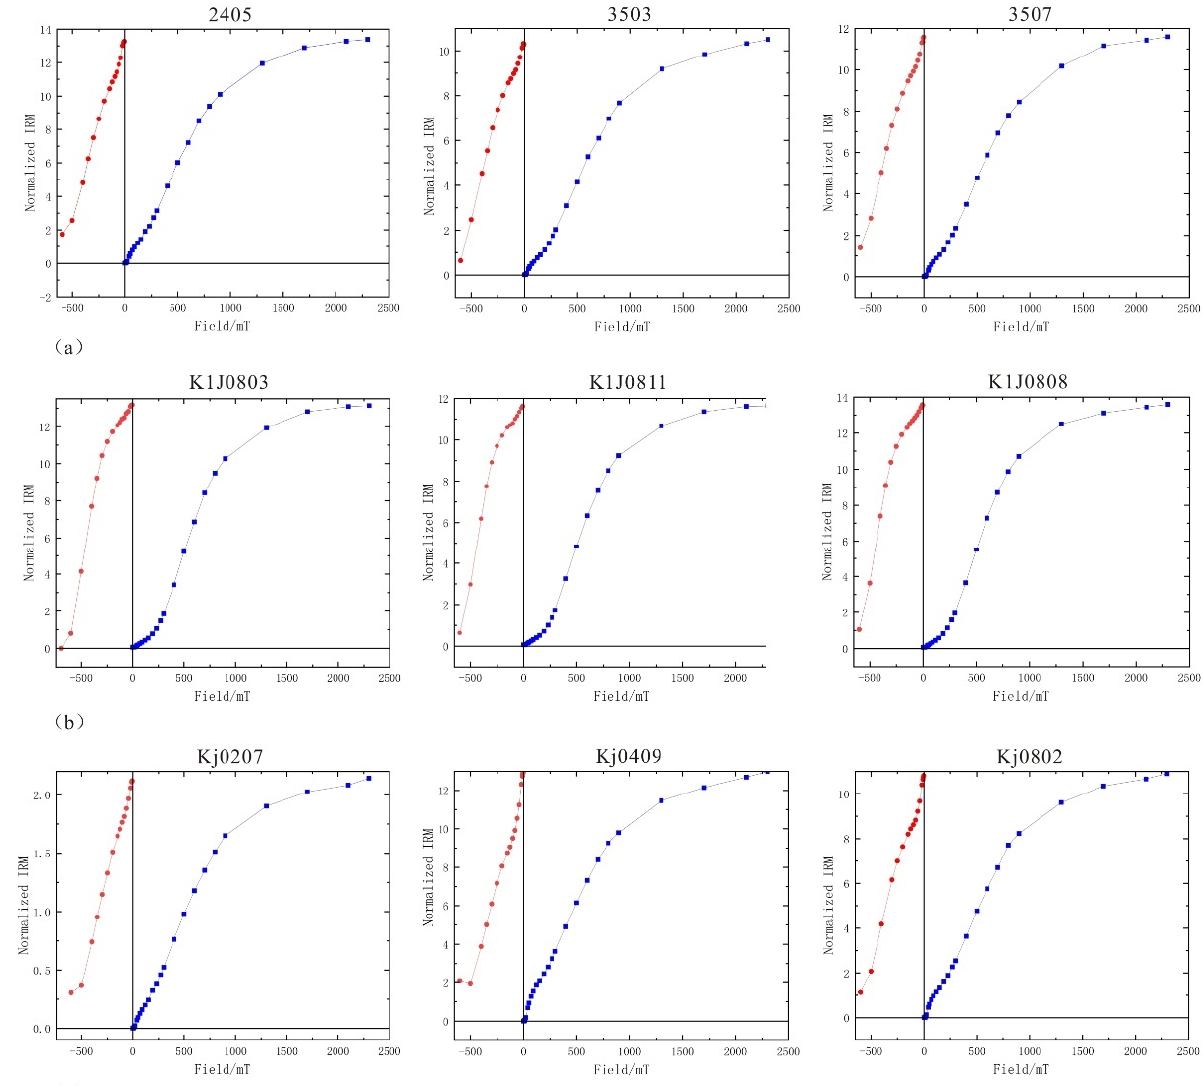
Figure 5. The characteristics of the experimental curve for the saturation isothermal remanence. ( a ) Samples from southern collection site; ( b ) Samples from Coqen Basin; ( c ) Samples from northern collection site. Red dots represent the magnetization in a weakened field; Blue dots represent the magnetization in an enhanced field.